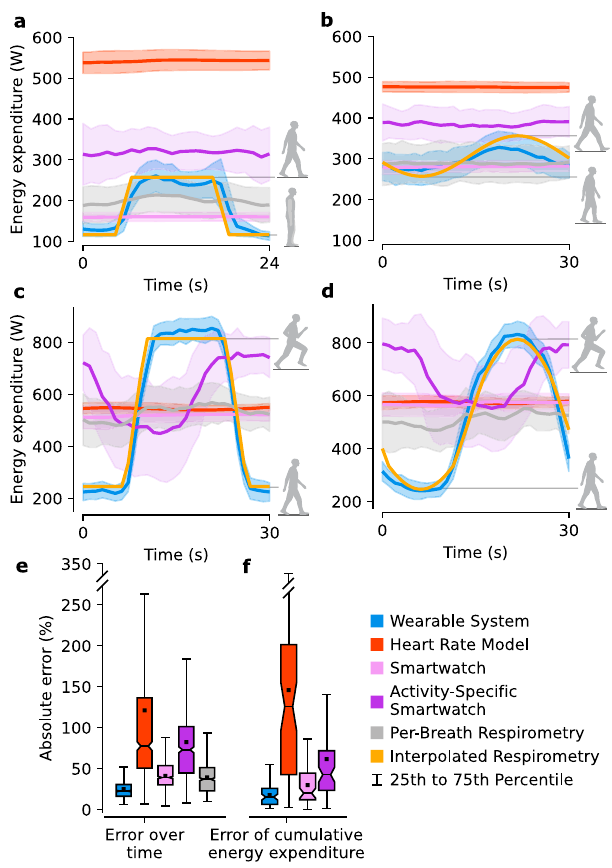
Fig. 3 Estimating energy expenditure during time-varying conditions. The time-varying conditions consisted of periodic pro fi les of treadmill speeds including a discrete steps between quiet standing and walking, b sinusoidally varying walking, c discrete steps from walk to run, and d sinusoidally varying walk to run. The mean and standard deviation of each estimation method is represented as a line with error bands. Interpolated Respirometry approximated ground truth by interpolating between subject- speci fi c Steady-State Respirometry values from walking and running conditions based on treadmill speed. The error pro fi les represent one standard deviation. e The error over time represents the mean absolute percent error between estimates from each method and the Interpolated Respirometry ( n = 24 subjects). f Cumulative energy expenditure error was computed as the mean absolute percent error between cumulative estimates for each method and Per-Breath Respirometry ( n = 24 subjects). The boxes extend from the lower to upper quartile values of the data, with a line at the median and a dot at the mean. The whiskers extend to the last data point within 2.5 times the interquartile range. Fliers were not plotted due to the wide range of